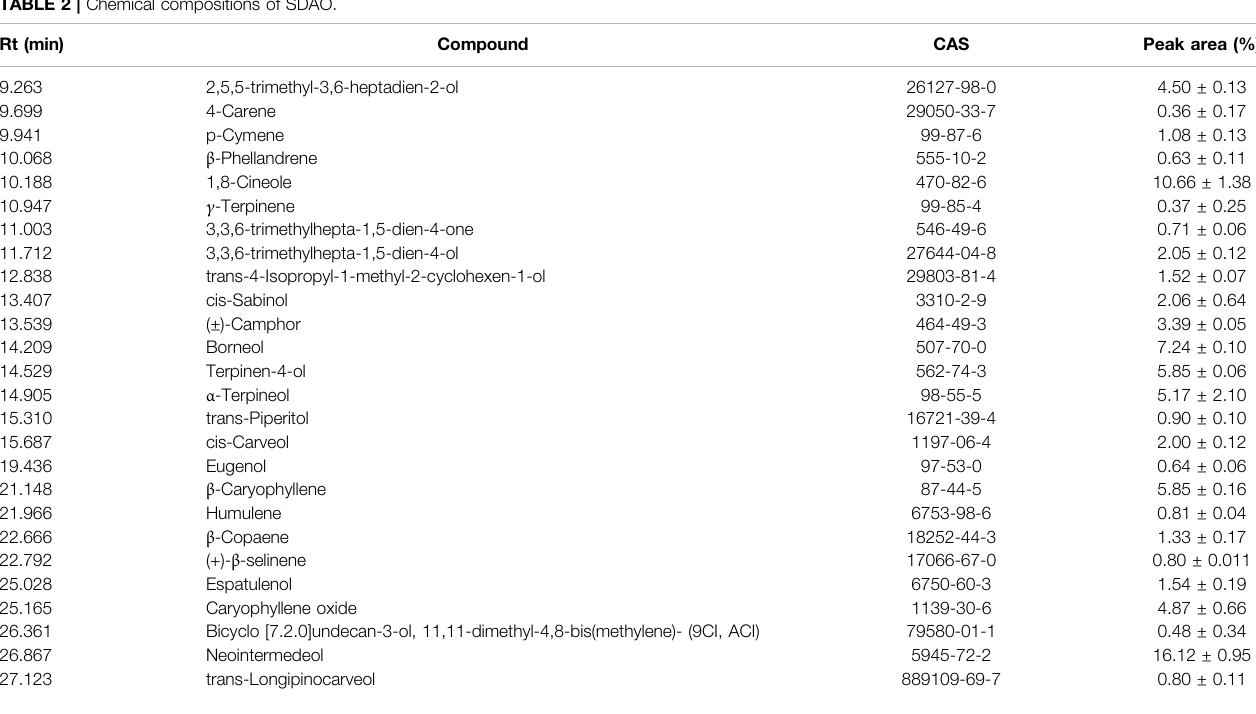
TABLE 2 | Chemical compositions of SDAO. Rt